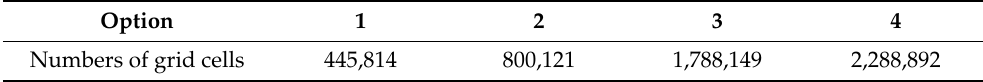
Table 3. Different grid number